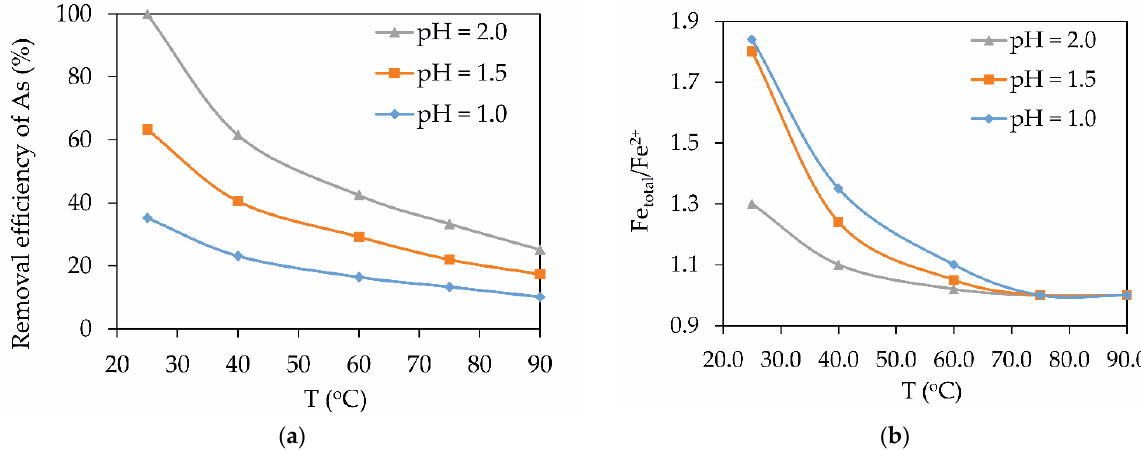
Figure 6. Dependence of the removal efficiency of arsenic (III) sulphide ( a ) and the ratio Fe total /Fe 2+ ( b ) in solution on temperature at a molar ratio of NaHS/As = 2.8.